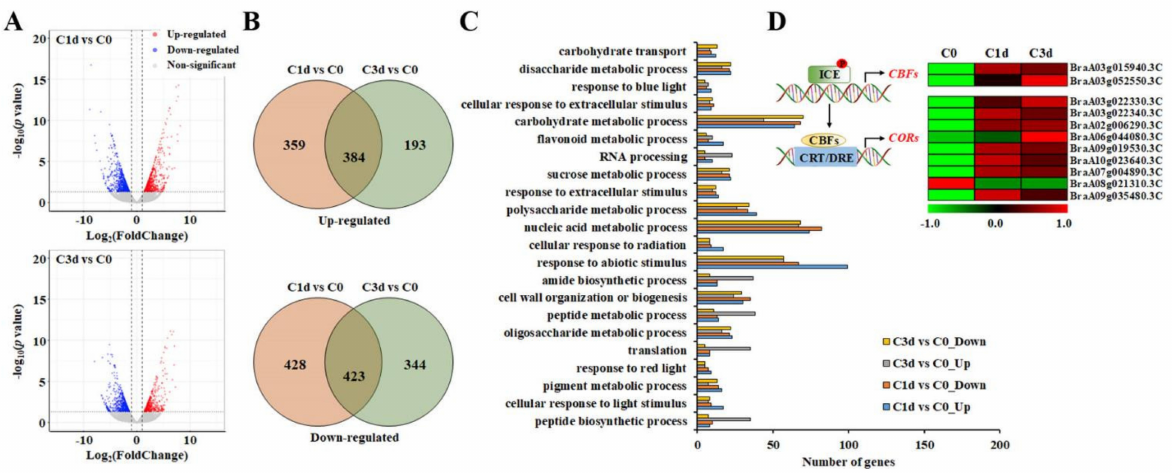
Figure 2. Cold-induced differentially expressed genes (DEGs) in heading type Kimchi cabbage. Volcano plot ( A ) and Venn diagram ( B ) analyses of the DEGs (C1d vs. C0, and C3d vs. C0). Gene ontology enrichment analysis of the DEGs ( C ), based on 2131 DEGs. ( D ) Expression heatmap showing the Z-scores of the DEGs involved in the ICE-CBF-COR cascade. C0, plants grown at 20 ◦ C (control plants); C1d and C3d, plants subjected to cold stress (10 ◦ C) for 1 day and 3 days, respectively. The color scale represents the raw Z-score ranging from red to green. Red and green colors indicate ascending and descending Z-scores,